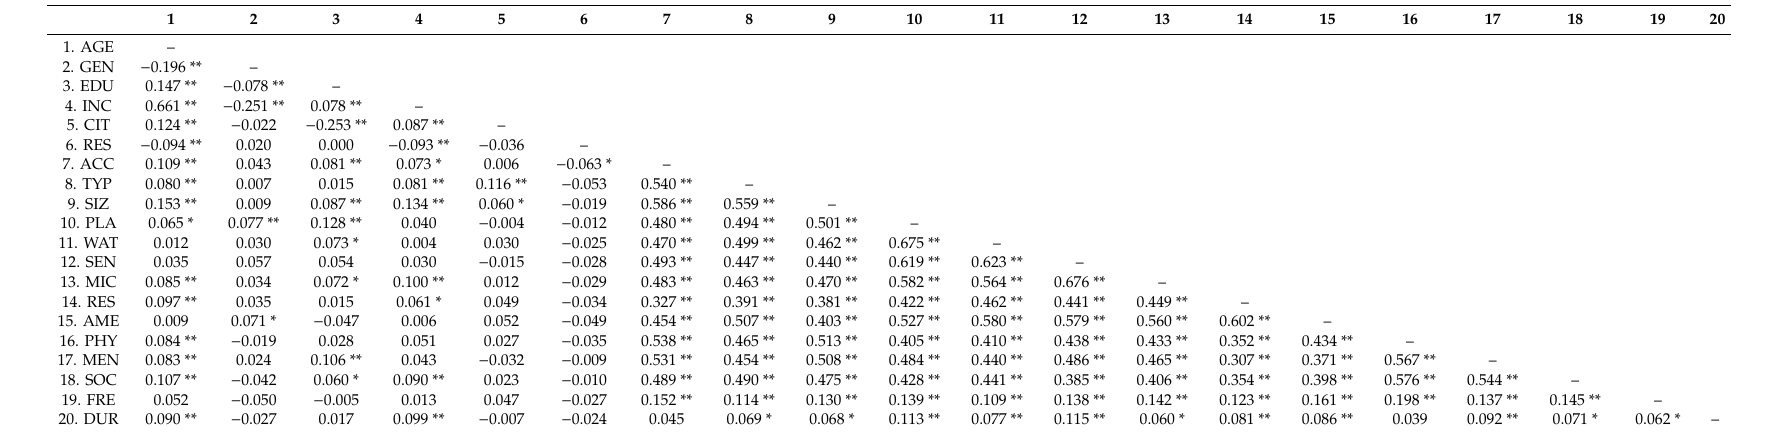
Table 4. Correlation analyses among the